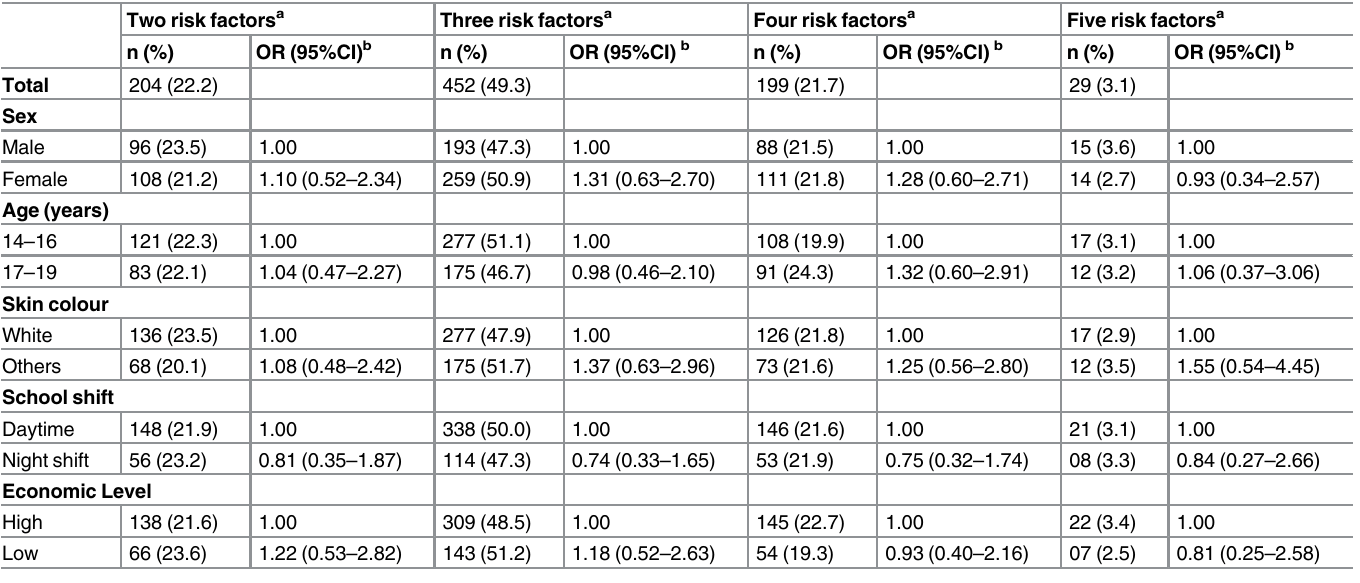
Table 4. Association between risk factors and demographic and socioeconomic variables in adolescents.